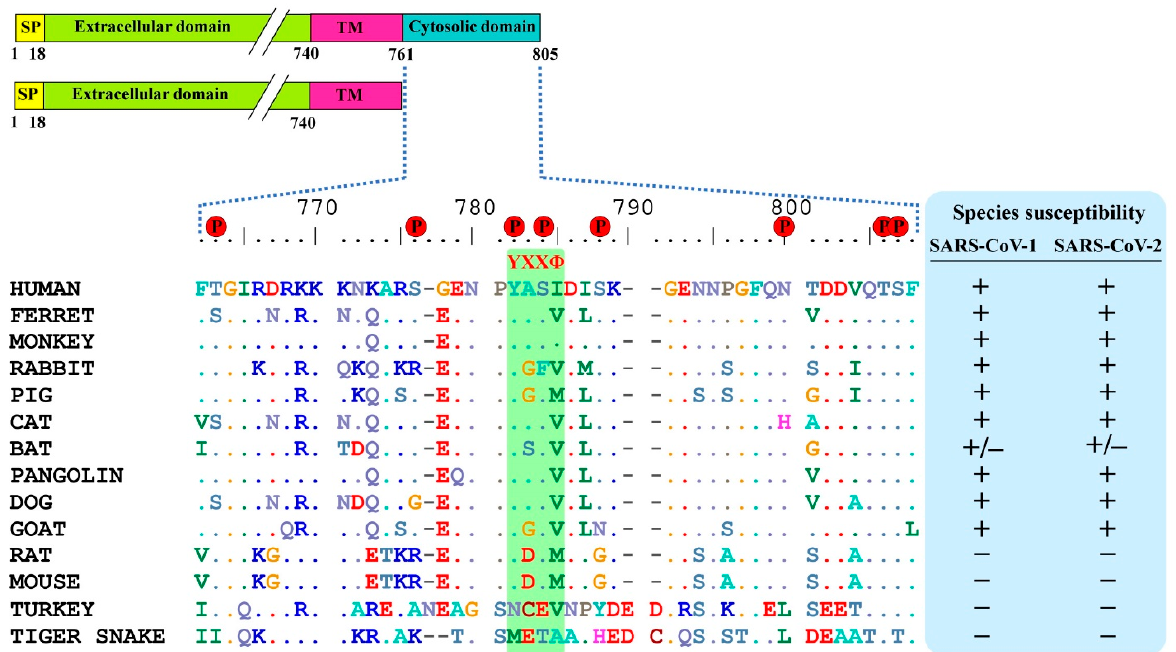
Figure 1. Comparison of conservative residues in ACE2 cytoplasmic domain of different species. Sequences were retrieved from NCBI and multiple sequence alignment was performed using the BioEdit software. Predicted putative phosphorylation sites are indicated by red circle. Susceptible and non-susceptible species to SARS-CoV-1 and -2 are denoted in ‘+’ and ‘ − ’signs respectively.